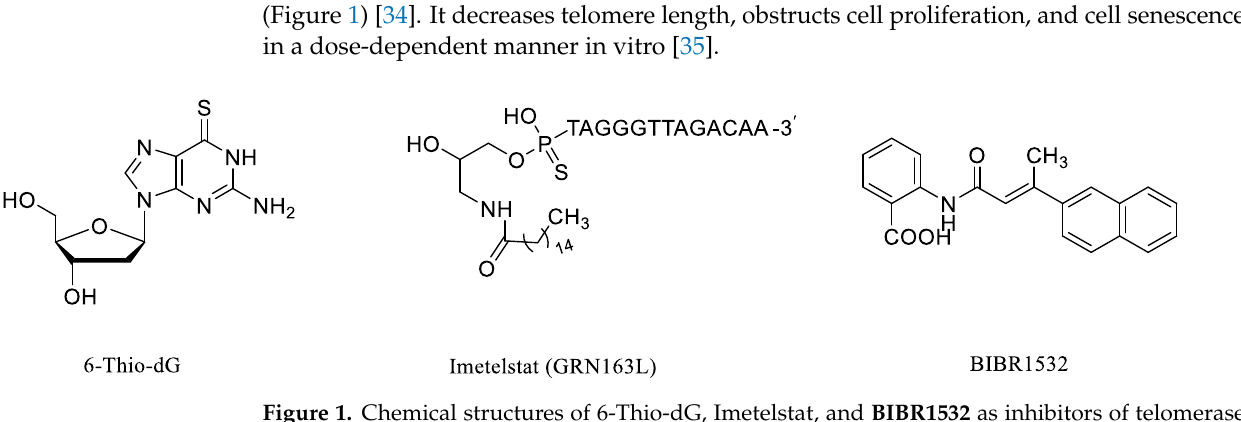
Figure 1. Chemical structures of 6-Thio-dG, Imetelstat, and BIBR1532 as inhibitors of telomerase enzyme.